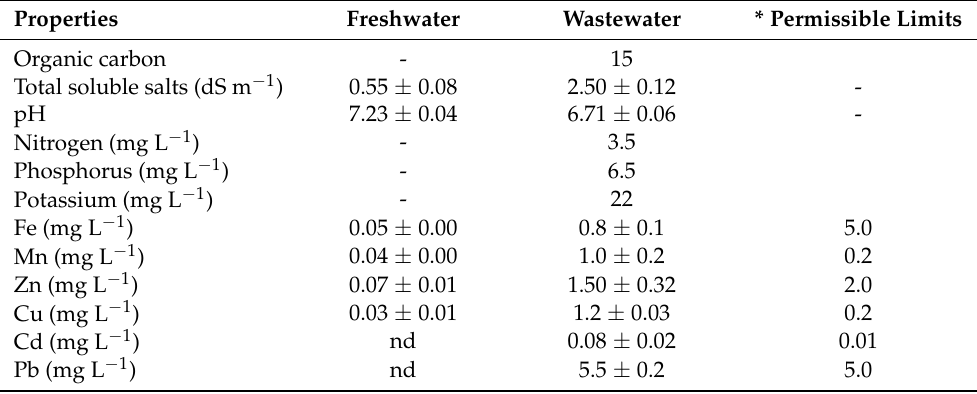
Table 3. Some chemical characteristics of fresh and